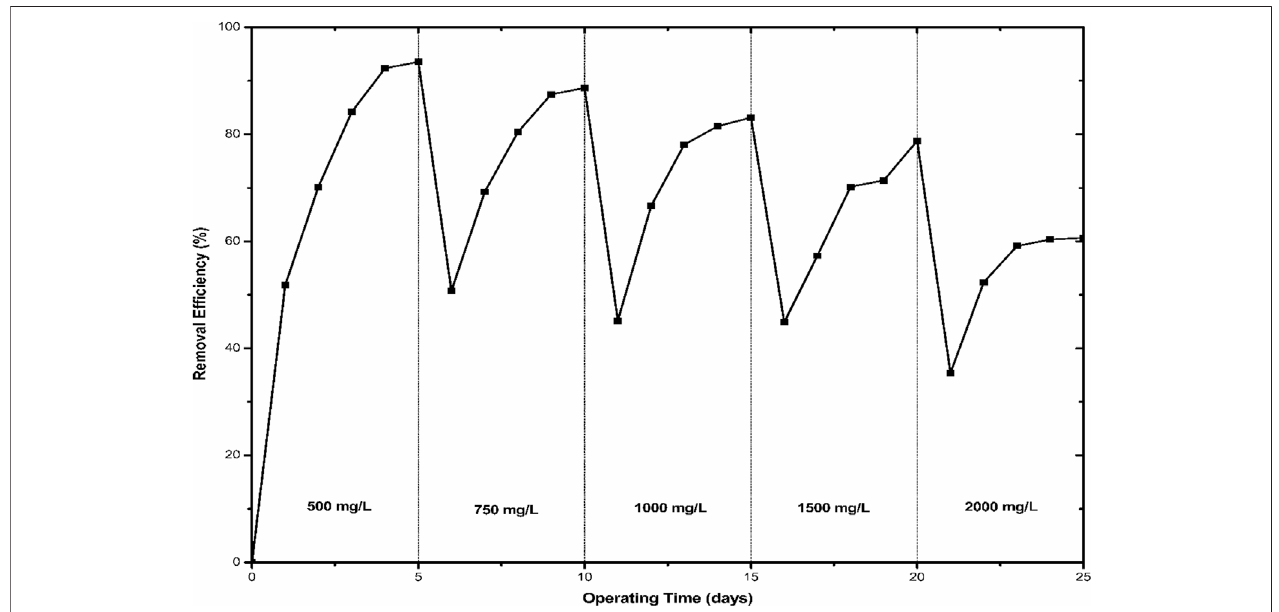
FIGURE 5 | Effect of initial butachlor concentration on the removal ef fi ciencies and elimination capacity of the PBBR.